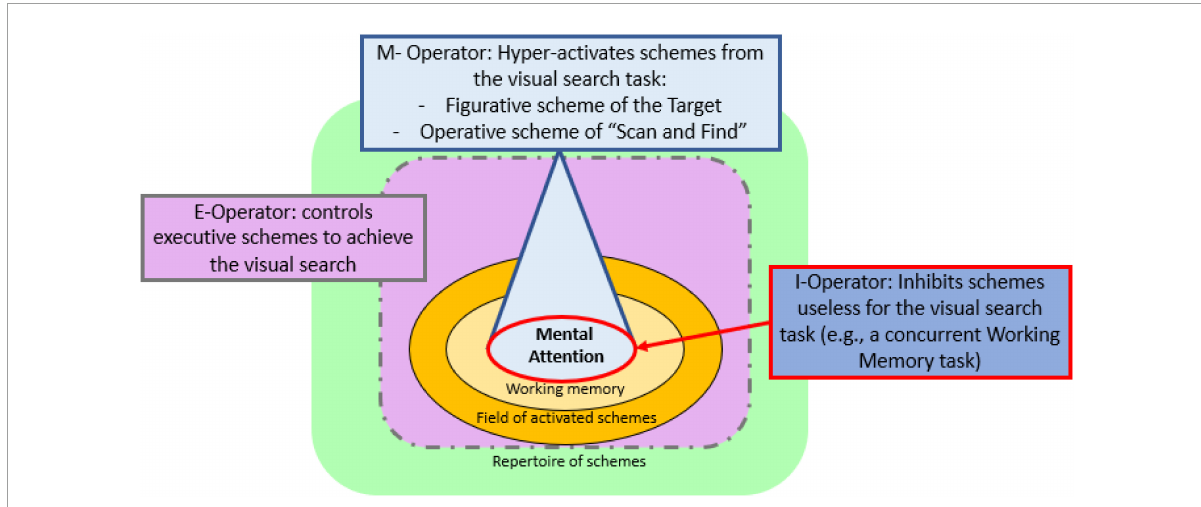
FIGURE1 Diagram of the functioning of the mental attention during a visual search task, based on the visual representations of the Model of Endogenous Mental Attention from Arsalidou et al. (2019) and Pascual-Leone and Johnson (2021).